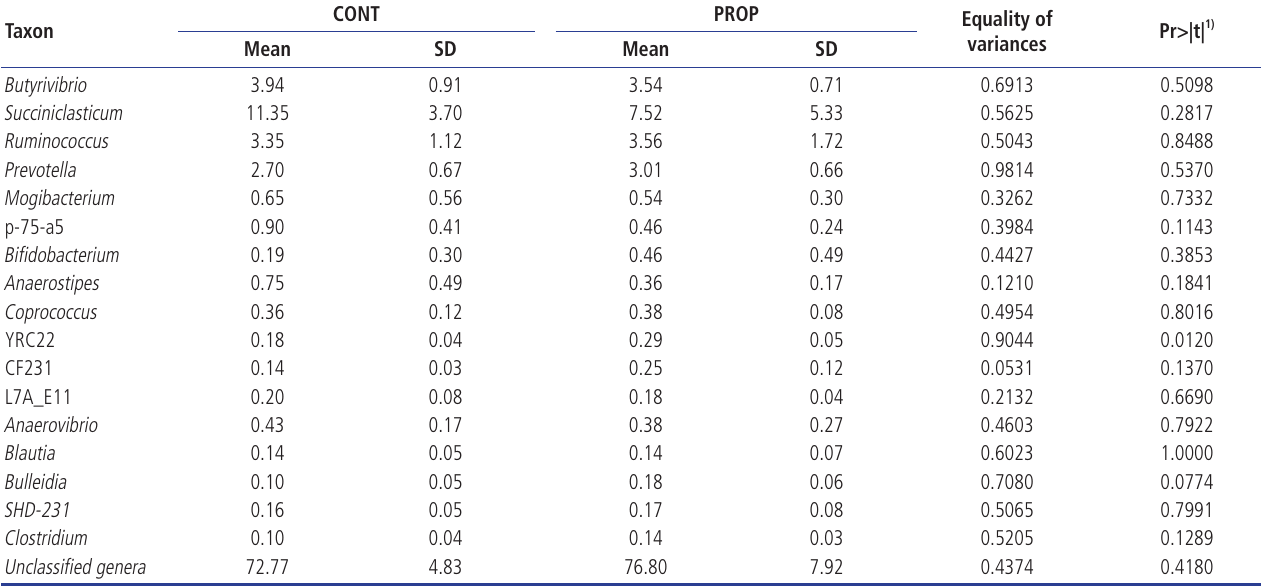
Pr>|t| 1) variances